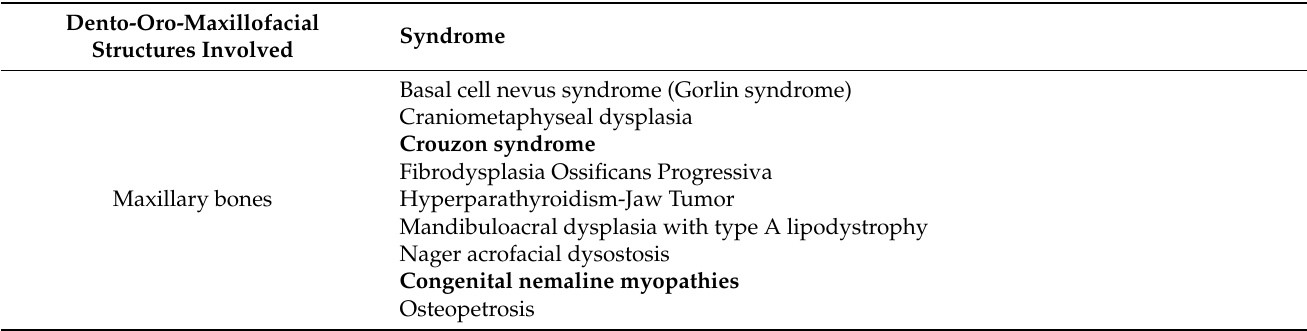
Table 2. Classification of rare genetic syndrome based on the involvement of dento-oro-maxillofacial